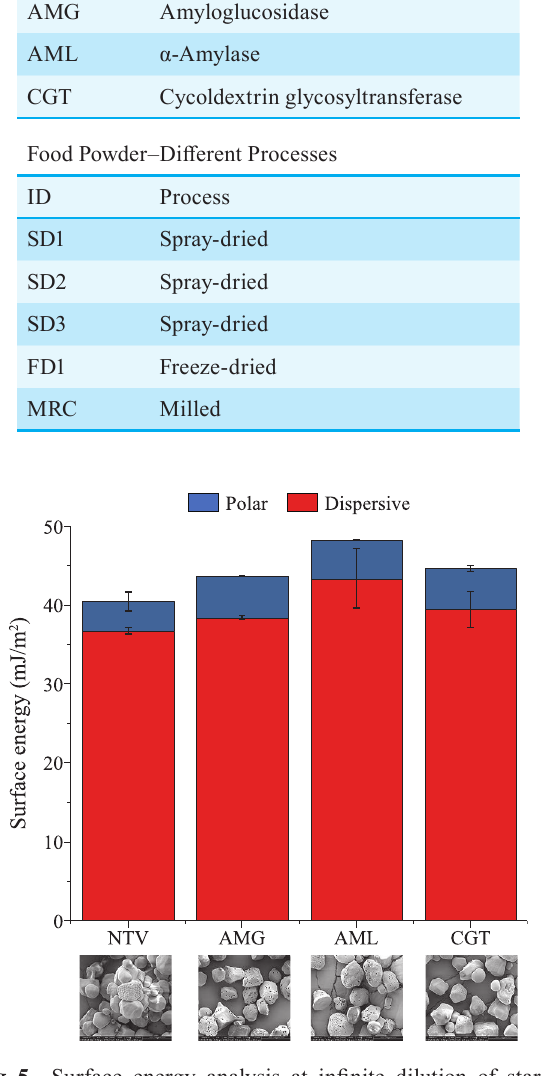
Fig. 6 Effect of surface composition on powder